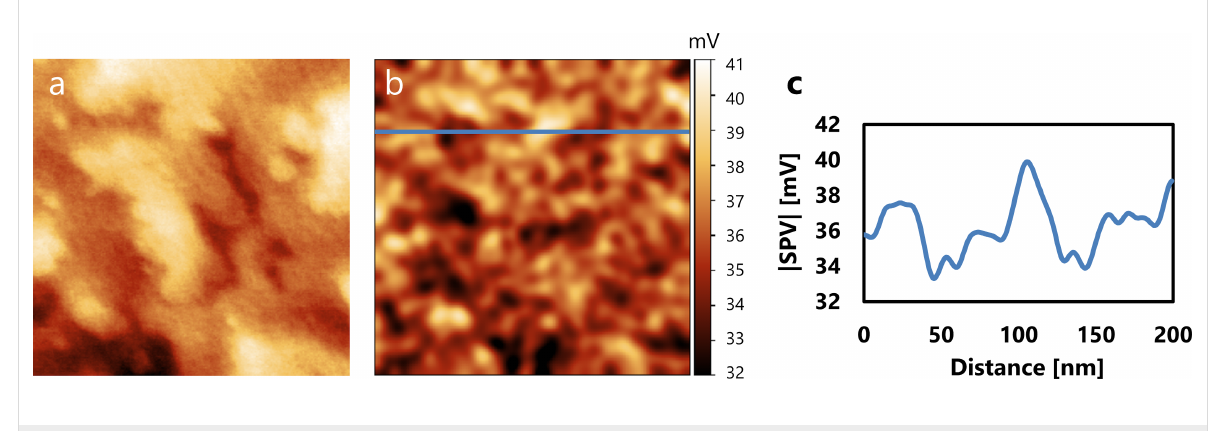
Figure 3: AC-KPFM imaging for SPV measurement. (a) Topographic and (b) SPV images of TiO 2 (110) surface. (c) SPV profile along the blue line in (b). The acquisition parameters are f m = 100 Hz, Δ f = − 80 Hz, V DC = − 0.3 V, and an imaging size of 200 × 200 nm 2 .